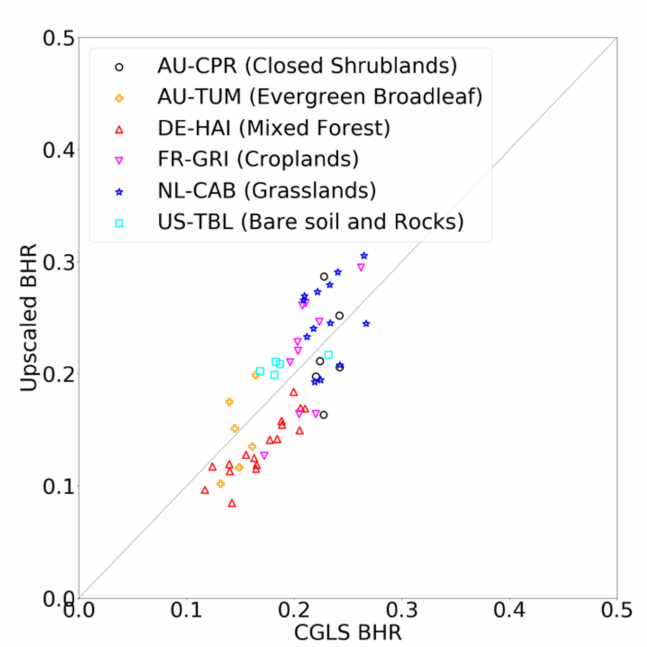
Figure 14. Summary of albedo results for BHRs upscaled from tower to CGLS spatial scale and BHRs from CGLS retrievals at selected tower stations with di ff erent land